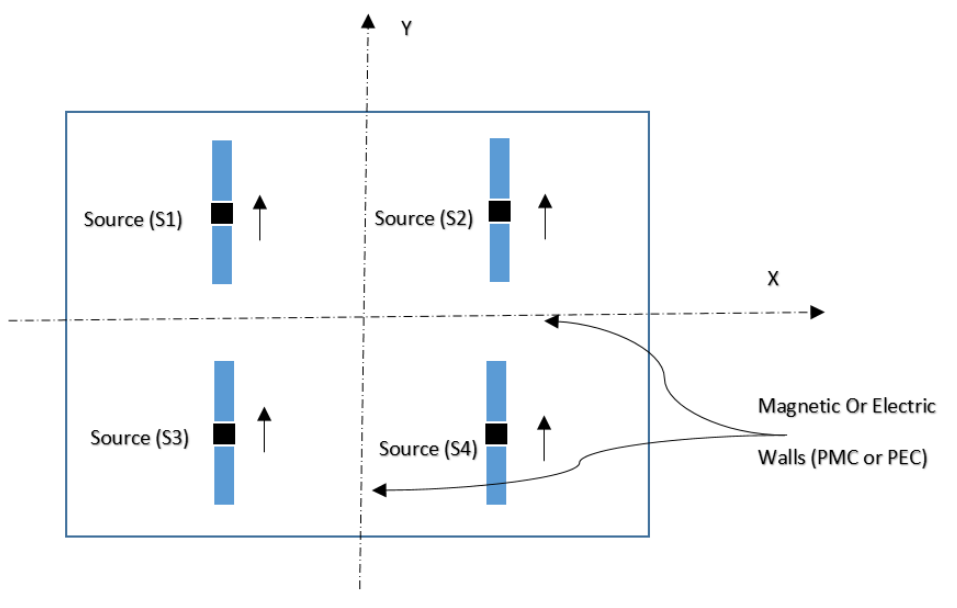
Figure 1. Four antenna configuration with a combination of electrical and magnetic symmetries